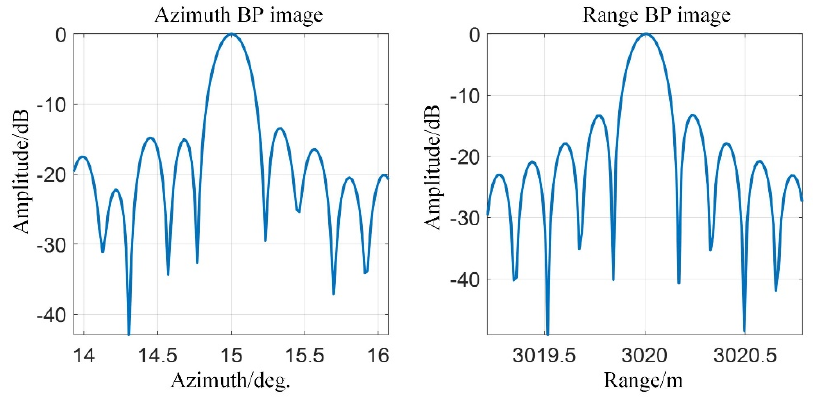
Figure 6. 2D profile of T4 after conventional calibration.